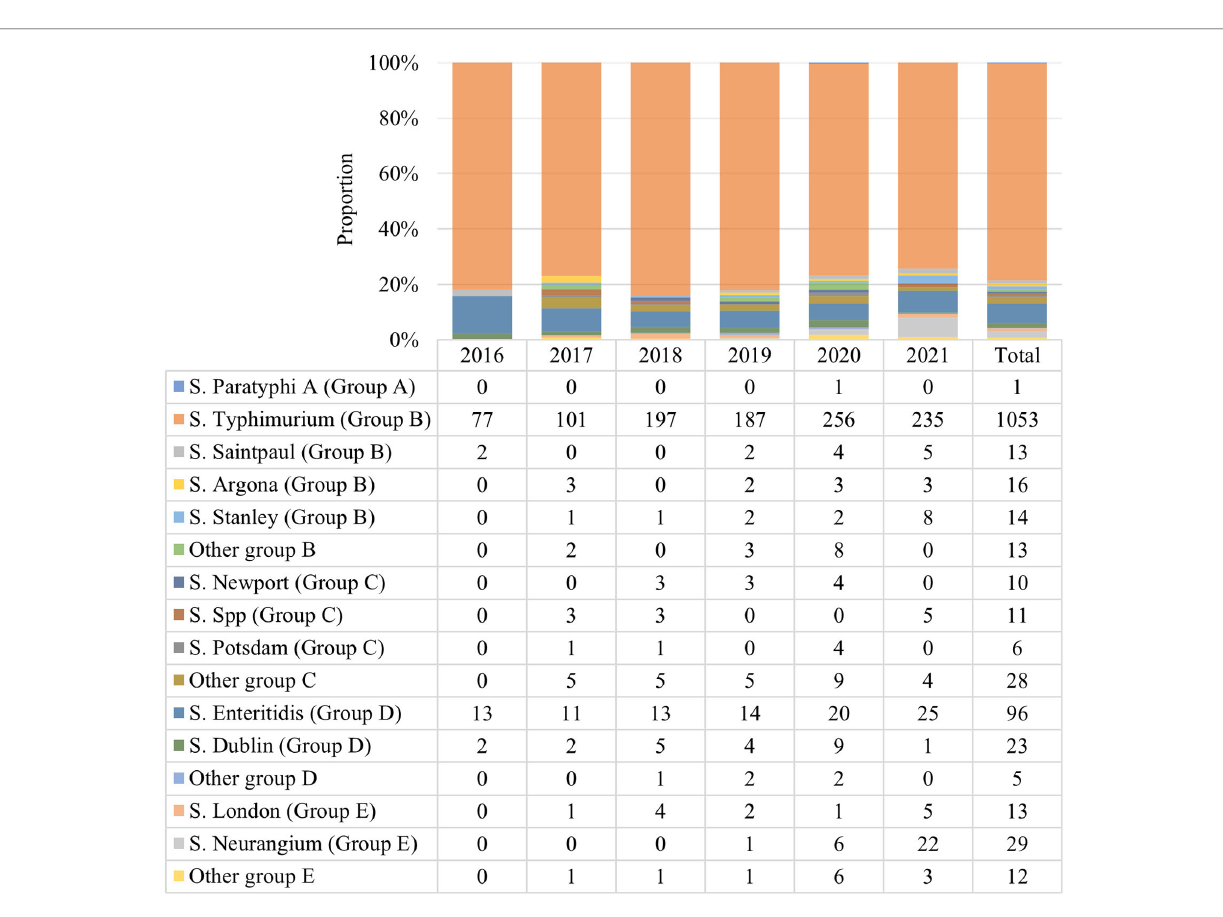
FIGURE 3 Serotype distribution of 1,338 Salmonella strains. 48 Salmonella serotypes were detected. This chart displays the major serotypes with different bar colors. Groups B and D were the top 2 predominant serogroups and S. Typhimurium was the predominant strain.